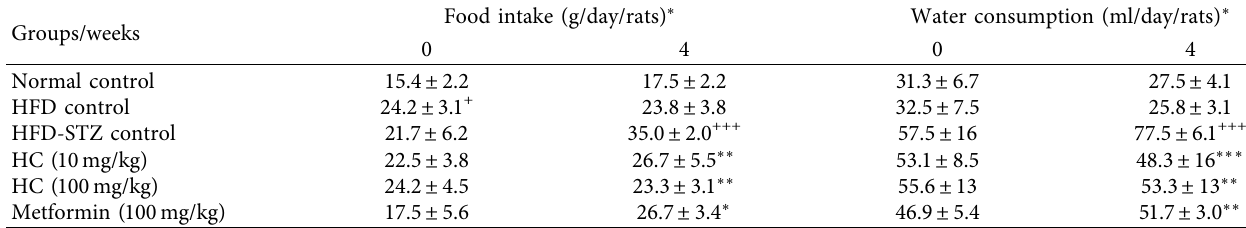
Table 2: The average food intake and water consumption in HFD-STZ-treated rats.